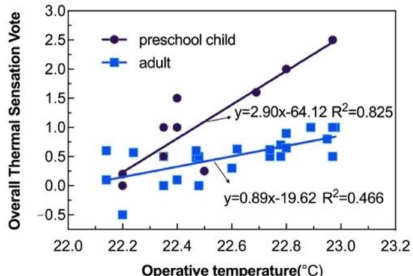
Figure 12. Change in the OTSV with the 𝑡 𝑜 .